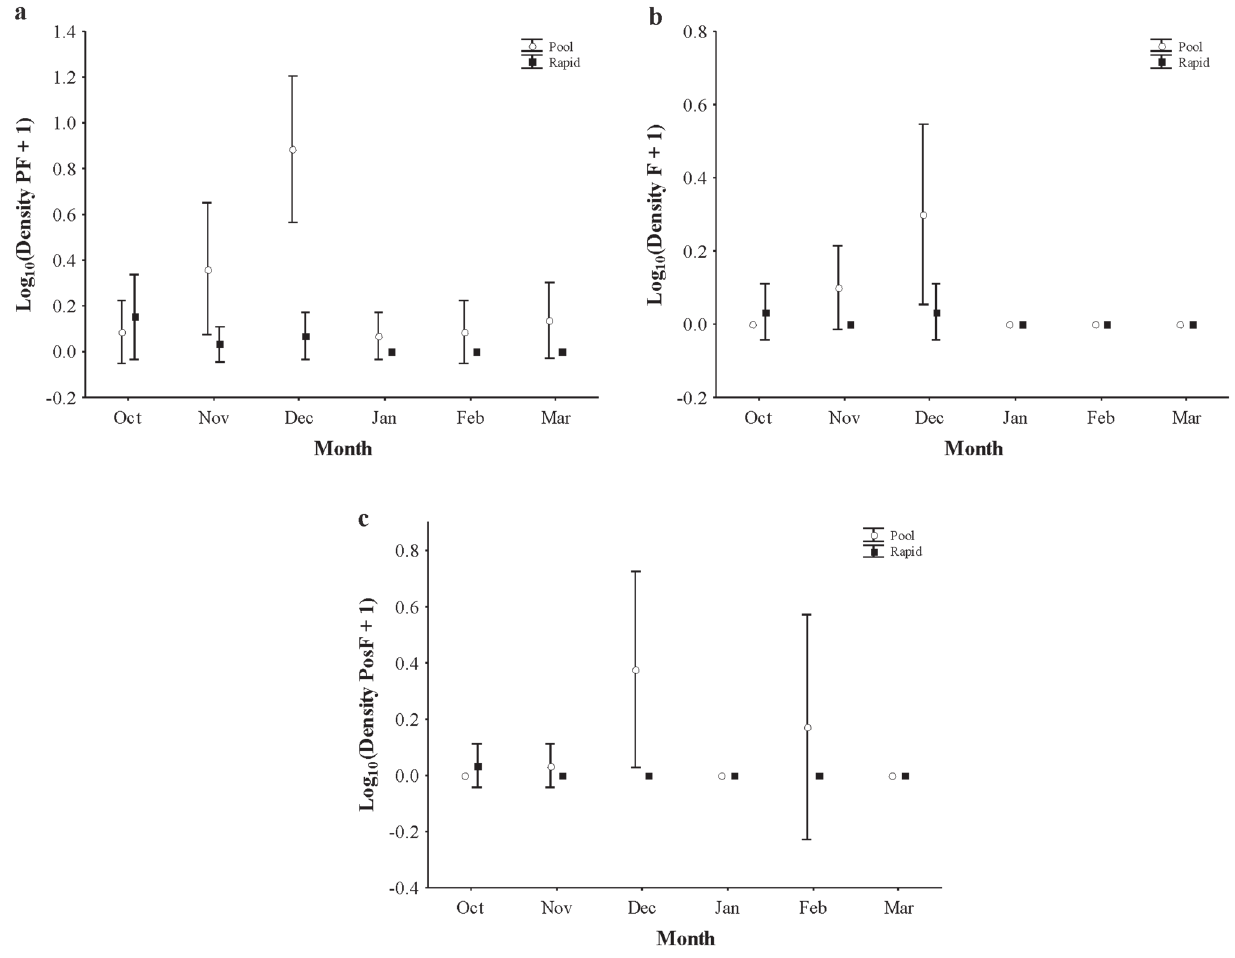
Fig. 9. Average density ± standard error of the different larval stages captured in the rapids and pool environments of the Peixe River. Period from October 2011 to March 2012. Larval stages: Preflexion (a), Flexion (b) and Postflexion